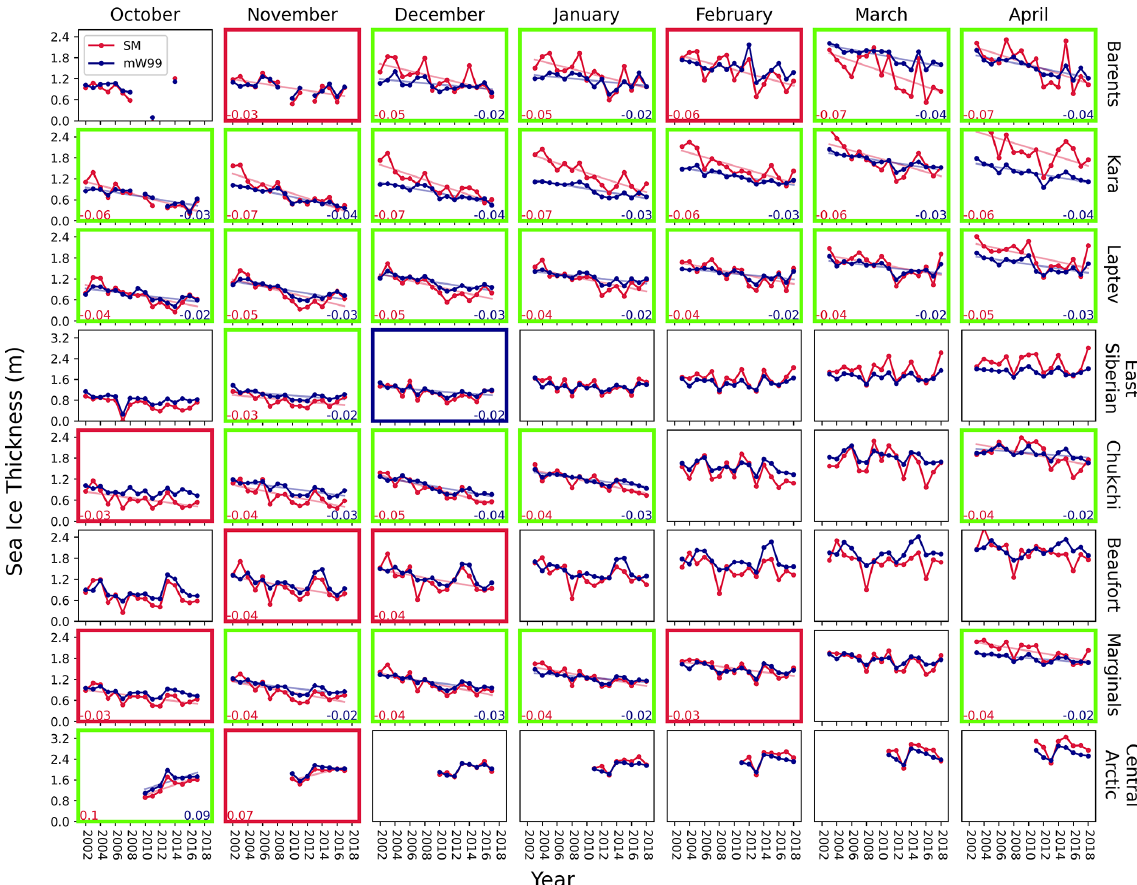
Figure 10. Regional SIT time series calculated using mW99 and SnowModel-LG. Note the different y -axis scale for the Central Arctic and East Siberian Sea. Panels featuring a statistically significant trend in sea ice thickness when calculated with both mW99 and SnowModel-LG are framed with green. Red frames indicate where the trend is only significant when calculated with SnowModel-LG. Blue frames indicate where a statistically significant increase is detected with mW99 but not with SnowModel-LG. Where trends are statistically significant, trend lines are